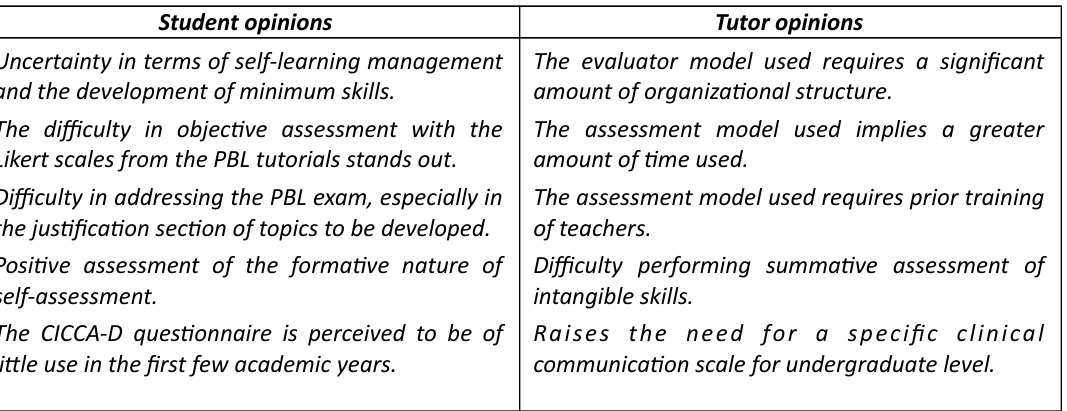
Table 2. Qualitatve assessment of students and tutors and teaching and evaluatve methodology employed We conducted a narratve analysis of the informaton and the results were discussed with the entre